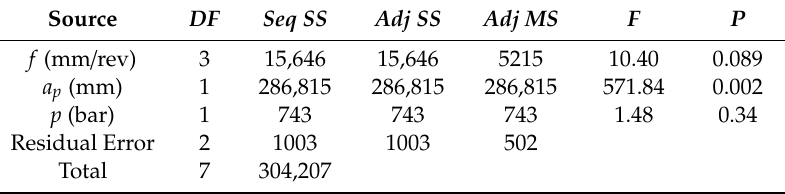
Table 6. Analysis of variance for mean values—feed force F f.